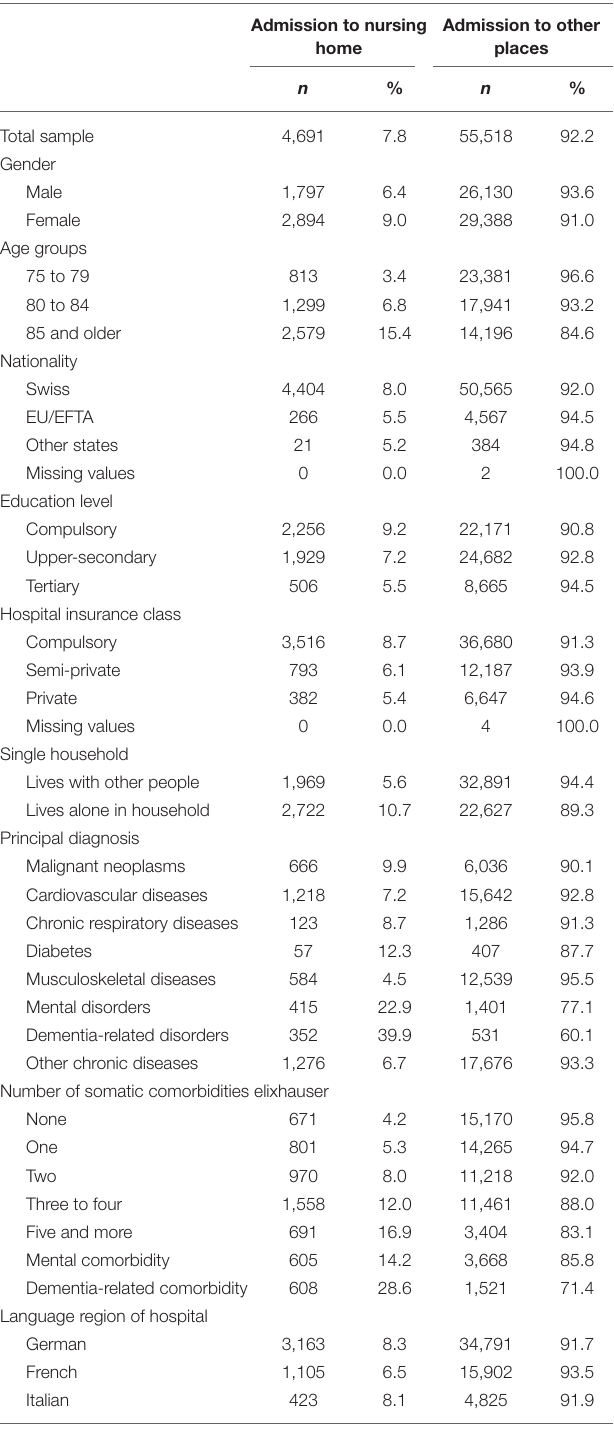
TABLE 1 | Descriptive characteristics of the study sample, N ,